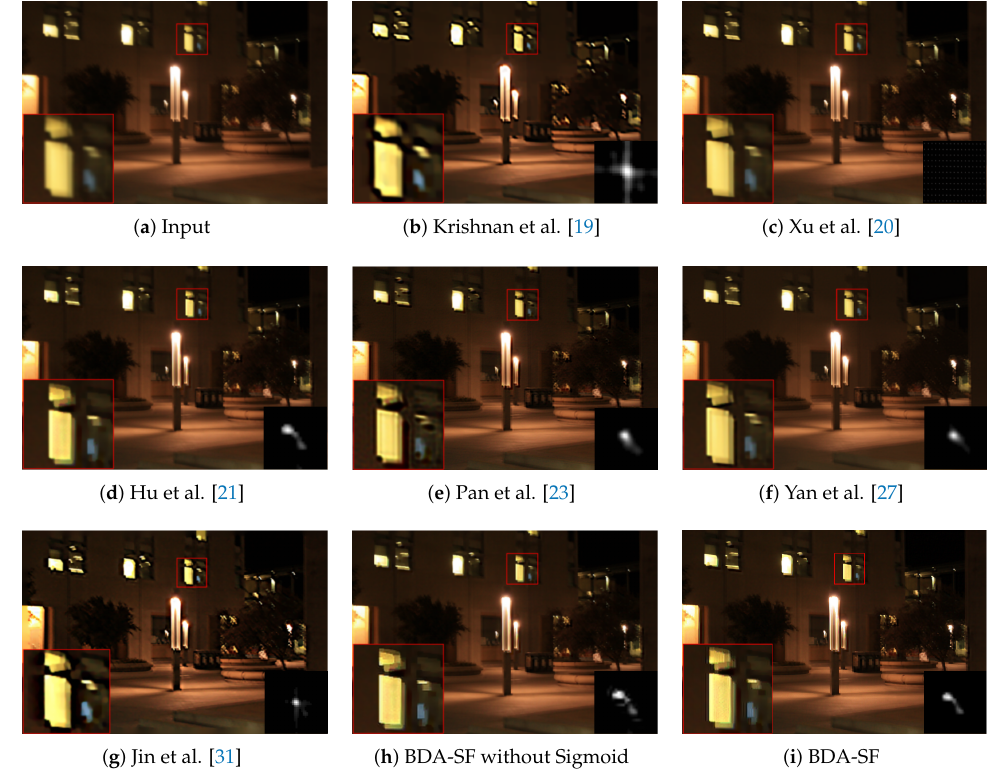
Figure 18. Visual comparison on a low-illumination image. BDA-SF achieves comparable visual results with method [21] which is specifically designed for low-illumination images. (Best viewed on high-resolution display with zoom-in).